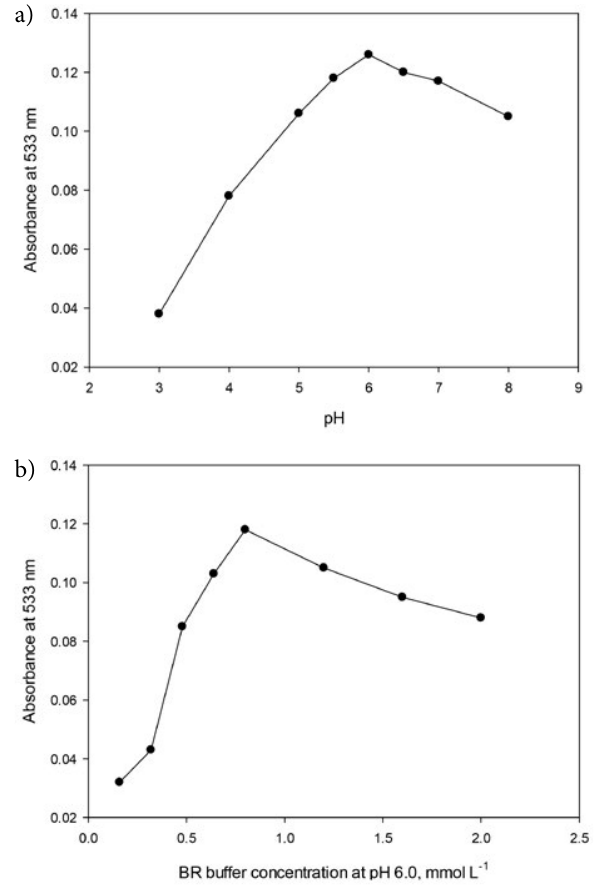
Figure 1. The influence of (a) pH and (b) B-R buffer concentration at pH 6.0 on the analytical signal. Conditions: 50 μg L –1 V(V), 1.6 µmol L –1 pyrogallol, 2.0 µmol L –1 safranin T, 6.0 mmol L –1 KCl solution, and 0.05% ( w/v ) Triton X-114 at 50 °C and incubation for 3 min.